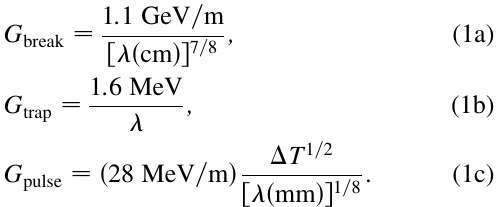
(cid:7) (cid:4) 3 = 2 p